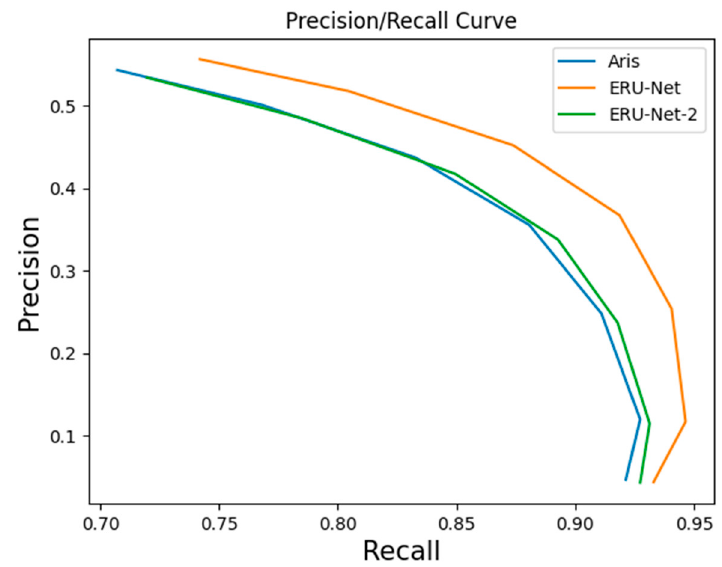
Figure 5. P-R curve of Aris’ method and ERU-NET.